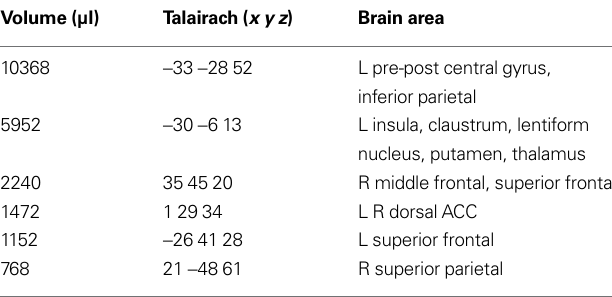
Table 2 | LOOM > STANDARD. Regions of signifi cant activation ( P < 0.001, corrected) for the contrast looming > standard signal.